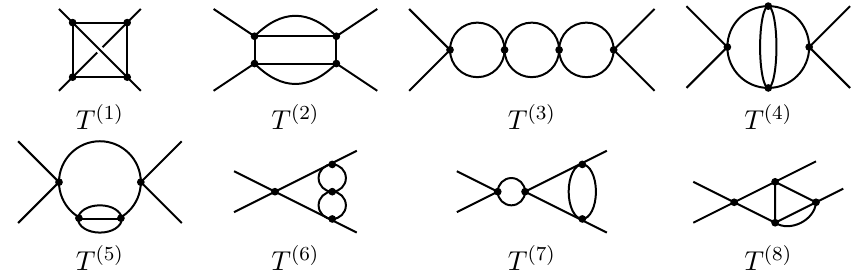
Figure 2 . Contractions of scalar interactions in (3.3) corresponding to three-loop quartic vertex